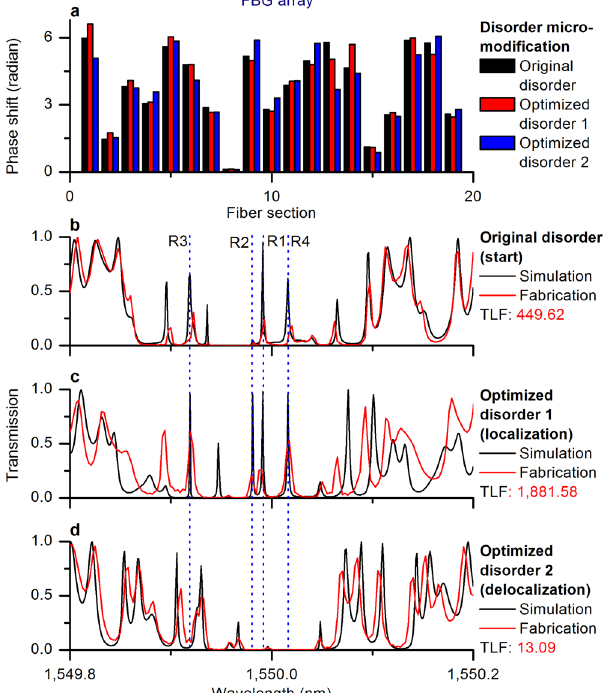
Figure 4. Two-way resonance optimizations between localization and delocalization of the FBG array. (a ) Original disorder and designed (optimized) disorders. ( b ) Resonances of original disorder (simulation and fabrication) before resonance optimization. ( c ) Resonances of optimized disorder 1 (simulation and experimental fabrication) after localization resonance optimization. ( d ) Resonances of optimized disorder 2 (simulation and fabrication) after delocalization resonance optimization. TLF: total localization factor.